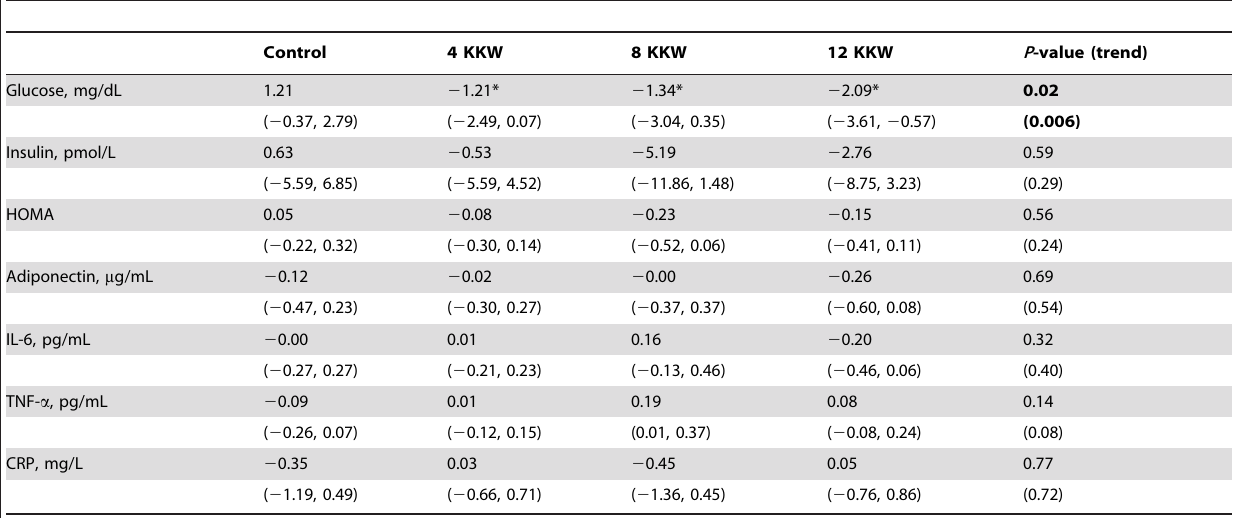
Table 4. Mean (95%CI) change in markers of fasting glucose metabolism and inflammation after 6 months of intervention.